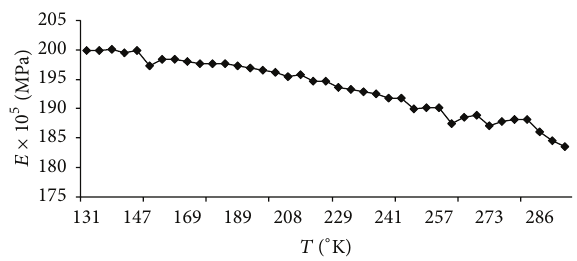
Figure 7: Temperature dependence of Young’s modulus for testing